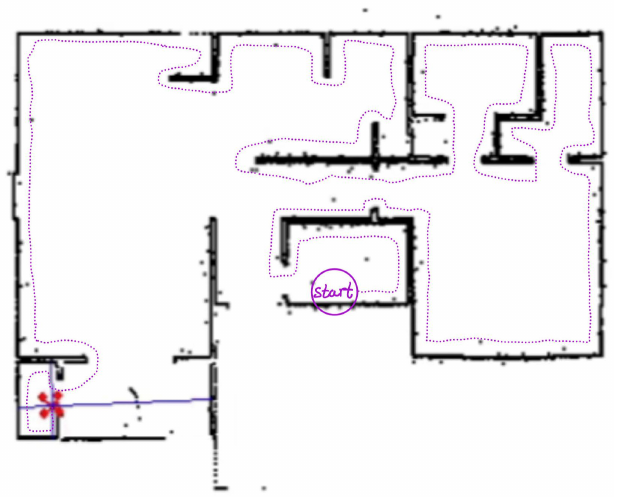
Figure 4. A 2D mapping of a building as computed in the simulator. BAT is marked in red, its path is marked by a dotted magenta trace, its current ranging is marked in blue rays, and the building 2D map is marked by black dots and lines.